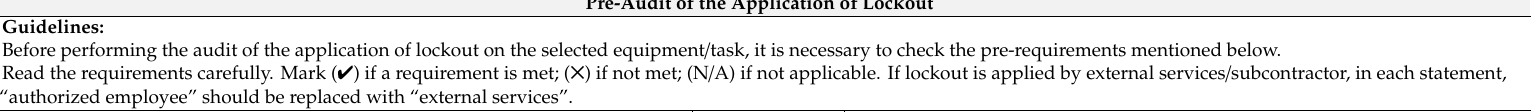
Table 4. Self-audit tool: Pre-audit of the application of